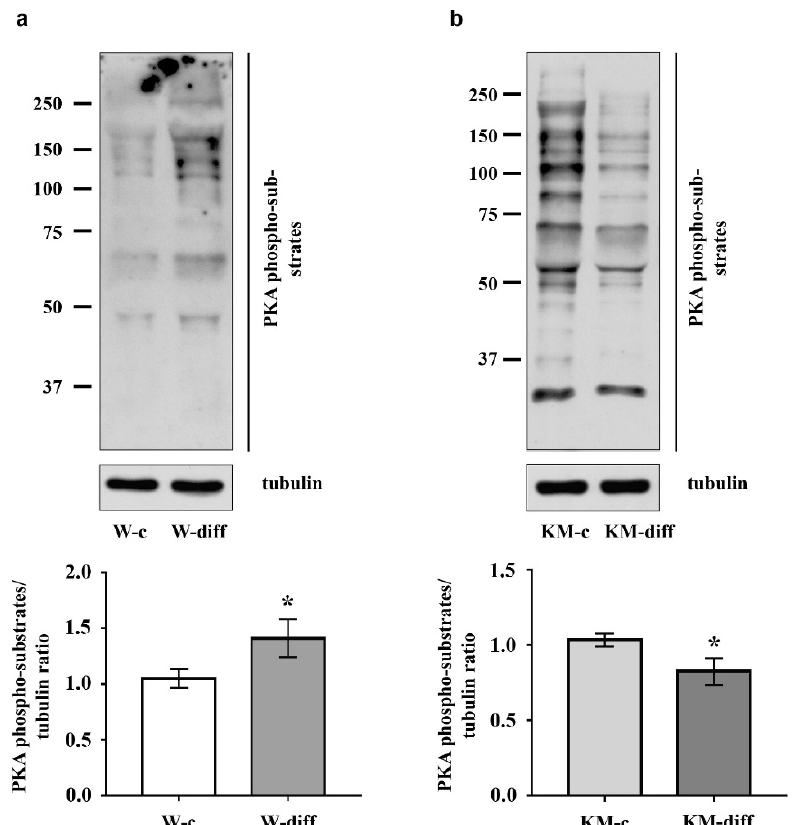
Figure 7. Evaluation of phosphorylated substrates of protein kinase A (PKA) in cultured NPC of Wistar and KM rat embryos. ( a ) Western blot analysis demonstrated increased phosphorylation of overall PKA substrates (PKA phospho-substrates) in Wistar NPC stimulated for glutamatergic di ff erentiation (W-di ff ) as compared with corresponding control (W-c). ( b ) In KM NPC glutamatergic di ff erentiation (KM-di ff ) was associated with lower content of phosphorylated substrates of PKA. Western blot data are calculated from three independent experiments. Results are shown as mean ± SD. * p < 0.05.